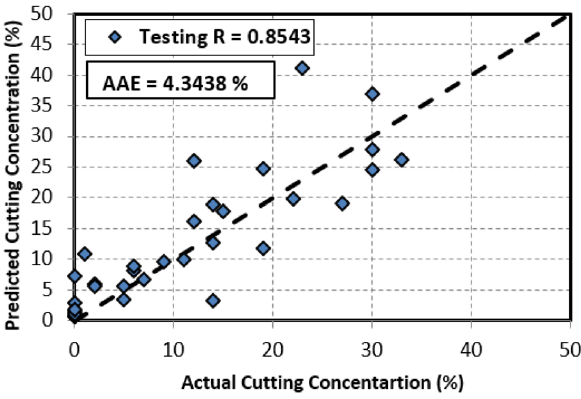
Fig. 12 RBFN-predicted versus actual (experimental) cutting concen- tration from testing